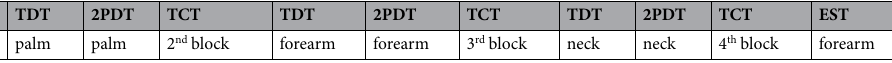
Table 1. Protocol outline of the